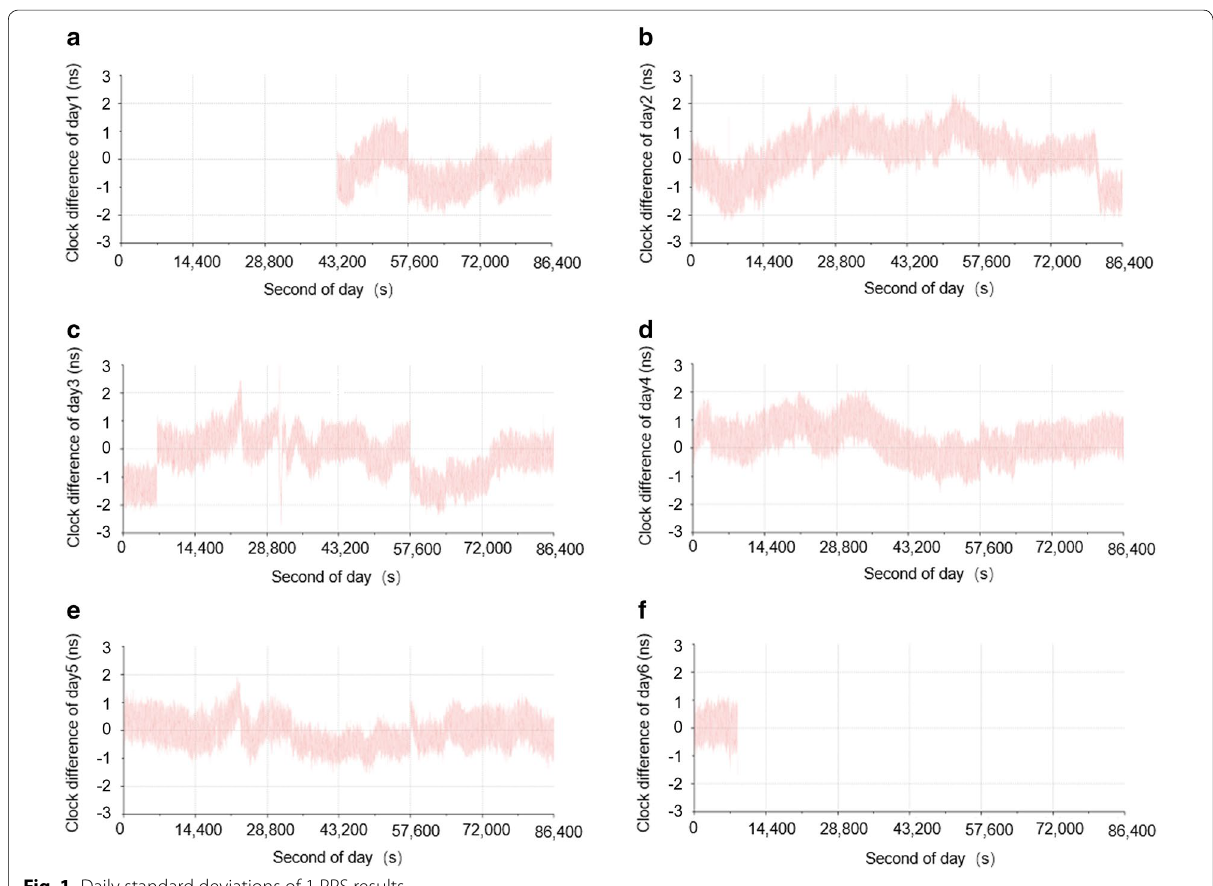
Fig. 1 Daily standard deviations of 1 PPS results